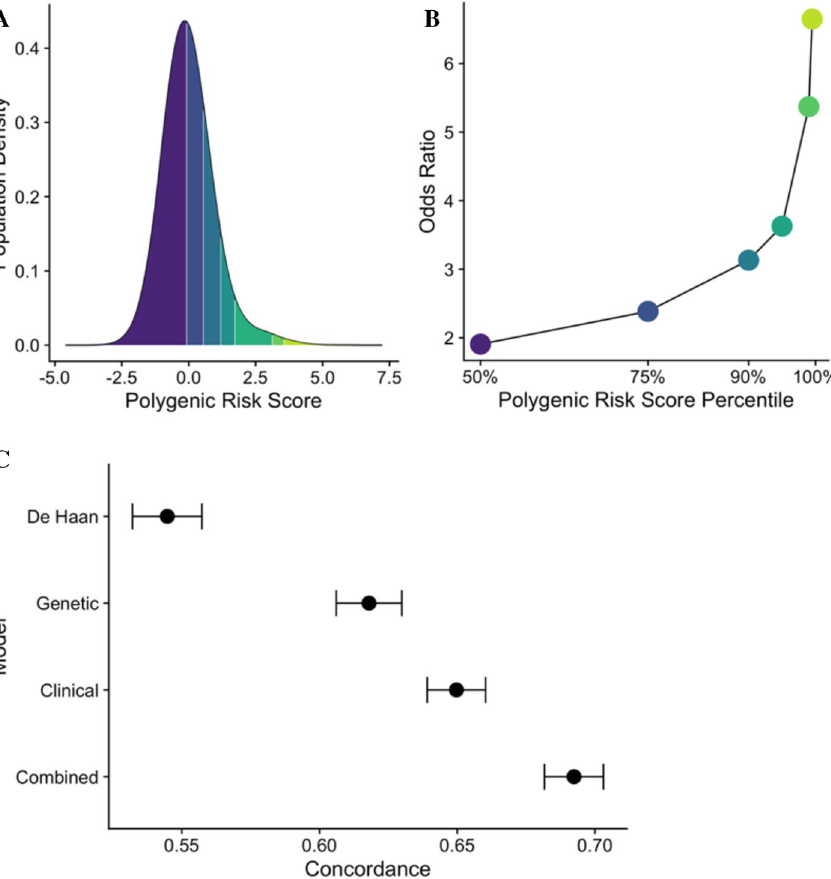
Figure 3. Model performance of a genetic, clinical, and combined score. ( A ) Shows the density of the polygenic risk score stratified by the 50th, 75th, 90th, 95th, 99th and 99.5th percentiles. ( B ) Shows the odds ratio for each polygenic risk score percentile. ( C ) Shows the concordance values, derived from Fine-Gray models, for the De Haan, genetic, clinical, and combined scores. The concordance of the combined model is significantly higher than the concordance of each of the other models ( P < 0.001). The I bars represent 95% confidence